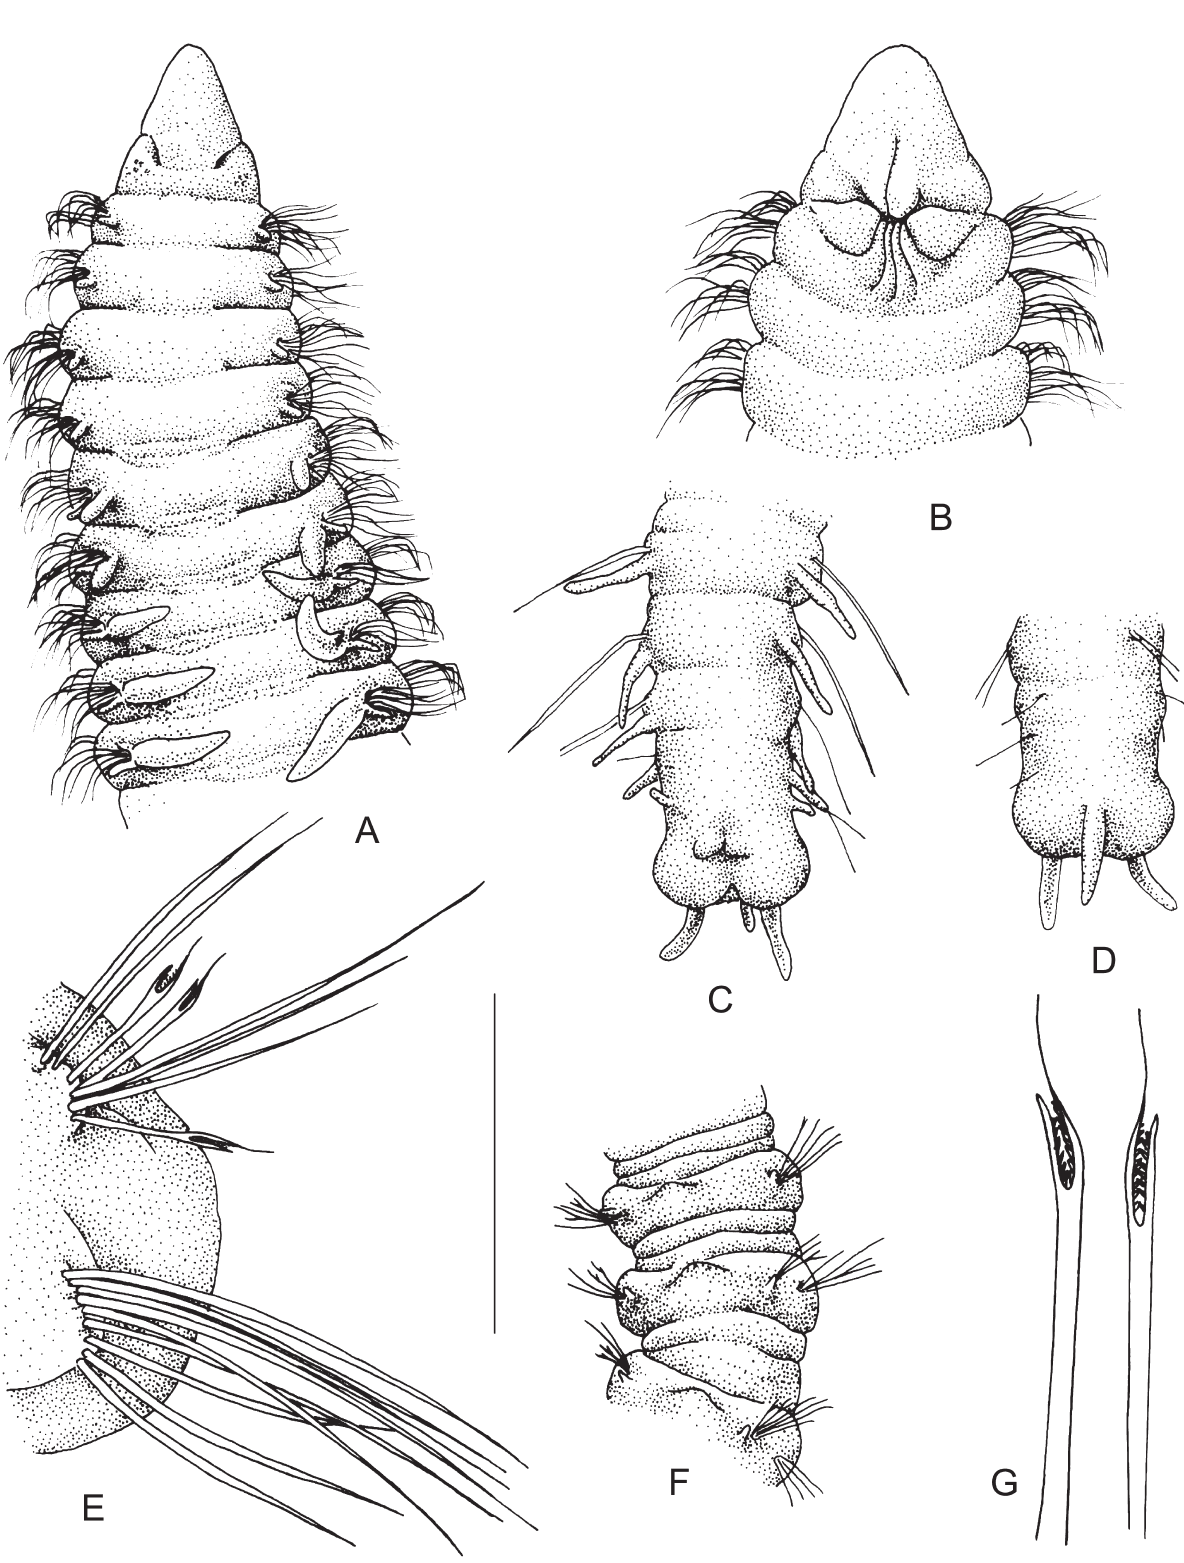
Fig . 12. – Paradoneis mikeli n. sp.: A, anterior region, dorsal view; b, anterior region, ventral view; c, posterior end, dorsal view; D, posterior end, ventral view; e, parapodium, chaetiger 31; F, postbranchial region, chaetigers 17-19, showing mid-dorsal folds; g, lyriform dorsal modi- fied chaetae, chaetiger 31. Scale bar: A 590 µ m; b 325 µ m; c 250 µ m; D 250 µ m; e 100 µ m; F 500 µ m; g 40 µ